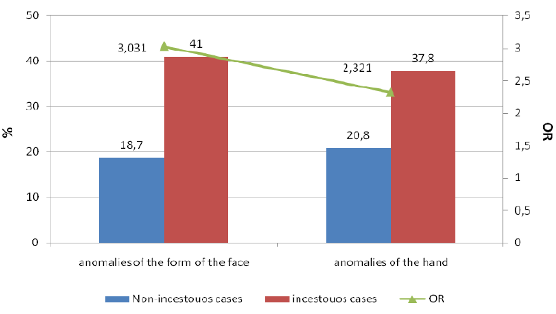
Figure 2. Consanguinity and associated anomalies in fetuses with NTDs.